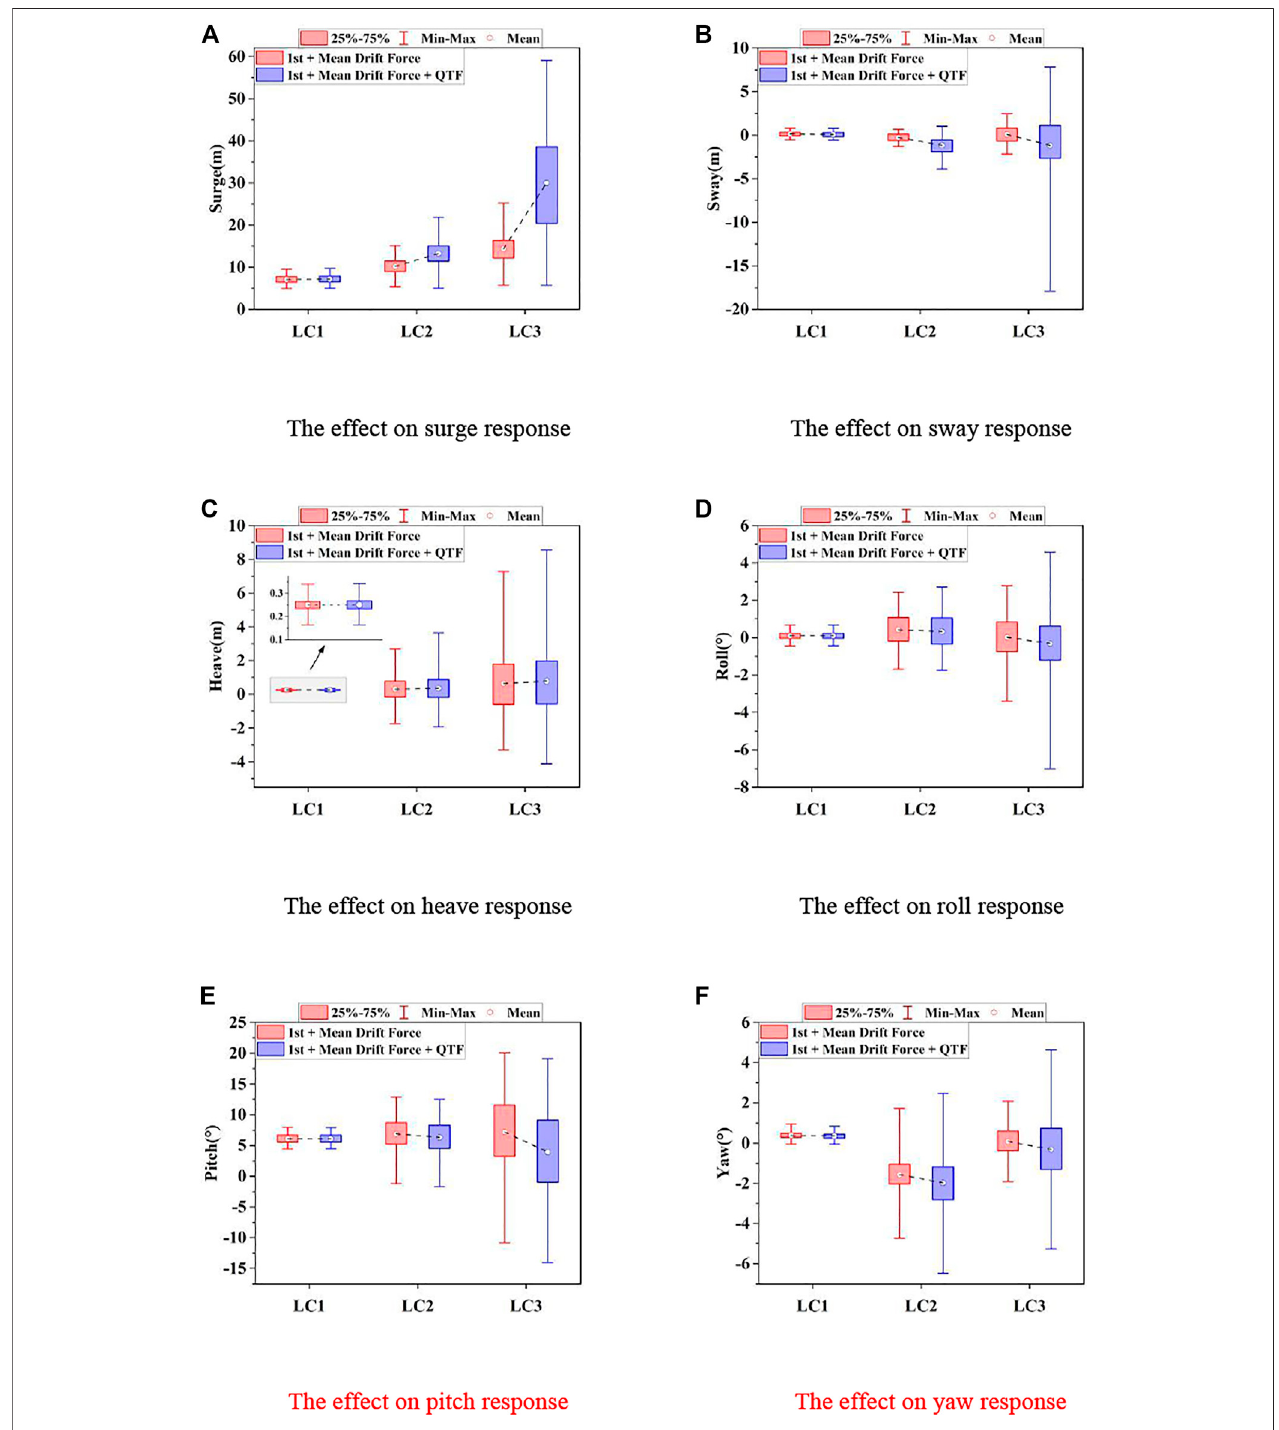
FIGURE 7 | Statistical results of the effect of the difference-frequency QTF on motion responses. (A) Effect on surge response. (B) Effect on sway response. (C) Effect on heave response. (D) Effect on roll response. (E) Effect on pitch response. (F) Effect on yaw response.